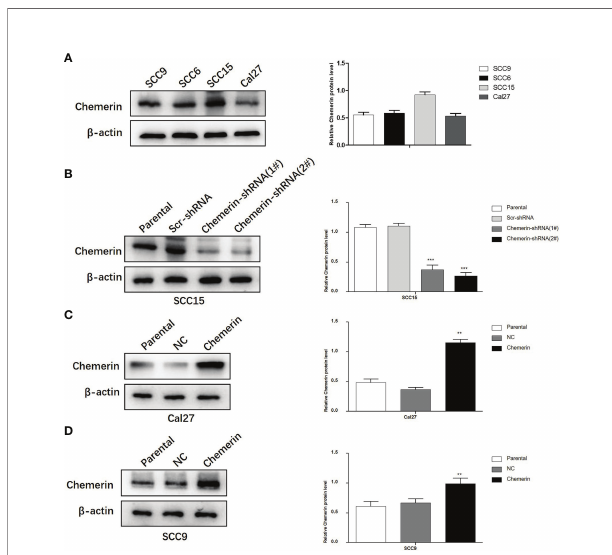
FIGURE 4 | The silencing and over-expression ef fi ciency of Chemerin in OSCC cell lines. (A) Western blot analysis of Chemerin protein expression in SCC9, SCC6, SCC15 and Cal27 cells. b -actin was used as the control. (B) The knockdown ef fi ciency of Chemerin-shRNA (1# and 2#) in SCC15 cell. In the following experiments, Chemerin-shRNA 2# was chosen because of its higher ef fi ciency in silencing Chemerin. Scr-shRNA was used as a negative control. (C, D) SCC9 and Cal27 cells were used to over-express Chemerin by lentivirus, and Western blot analysis showed the expression of Chemerin increased after Chemerin transfection (* P < 0.05; ** P < 0.01; *** P < 0.001). NC was used as a negative control. All data were presented as mean ± SD. All the experiments were repeated three times.